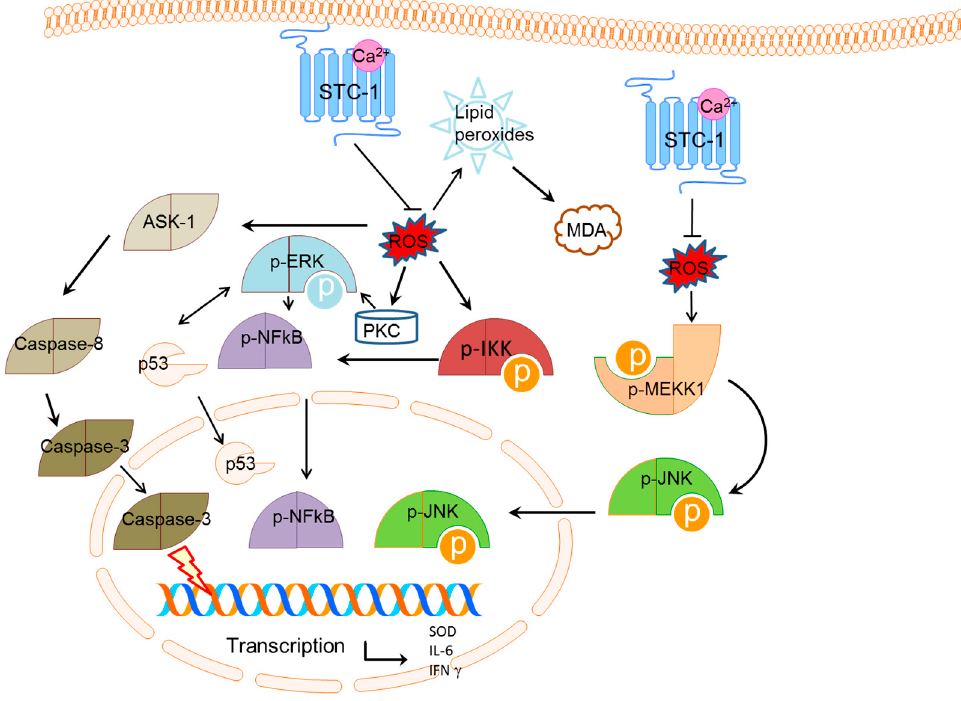
Figure 6. STC-1 acts a modulator for renal injury via affecting ROS-mediated multiple pathways. STC-1 is an effective ROS scavenger, which affects the levels of phosphorylated mitogen-activated protein kinase kinase kinase (p-MEKK-1), c-Jun N-terminal kinase (p-JNK), nuclear factor (NF) κ B, extracellular signal-regulated kinase (p-ERK), IkB kinase (p-IKK), apoptosis signal-regulating kinase 1 (ASK-1), p53 and caspase-3. STC-1 affects ROS-mediated IKK-NF- κ B, PKC-ERK-NF- κ B, ASK-1-NF- κ B, p53 and MEKK-JNK pathways, and improves anti-inflammation, anti-oxidant and anti-apoptosis activities by increasing level of superoxide dismutase (SOD) and reducing the level of capase-3, p53, interleukin-6 (IL-6) and IFN- γ